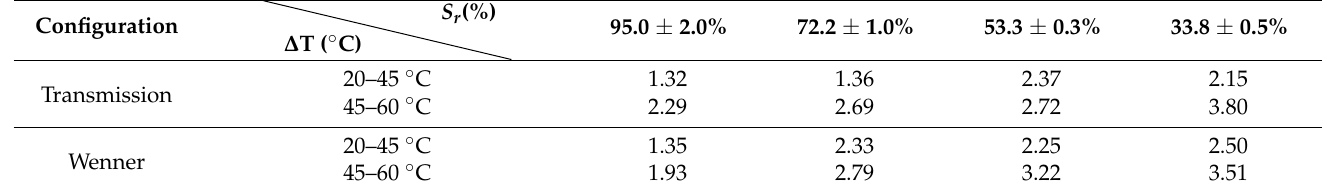
Table 4. Percentage change in resistivity per ◦ C at different degrees of saturation and in two separate ranges of temperature for the transmission and Wenner